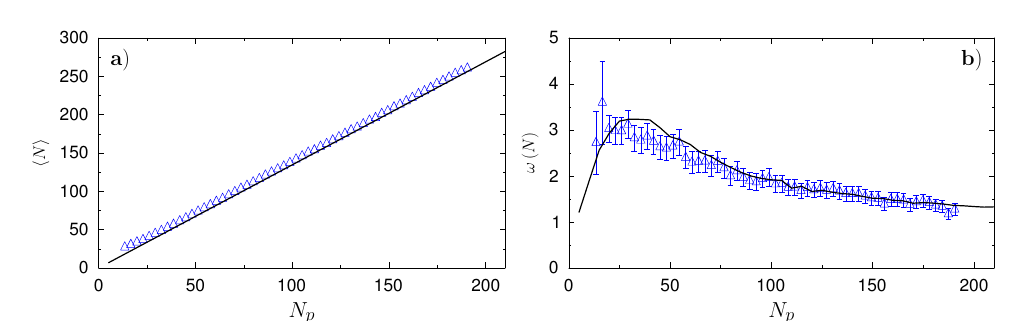
Figure 2. Average number of all charged particles (panel a)) and scaled variance of all charged multiplicity distribution (panel b)) of particles produced in Pb + Pb collisions plotted as a function of number of nucleons from projectile nucleus which participate in the collision. By triangles we indicate data of the NA49 experiment [3].